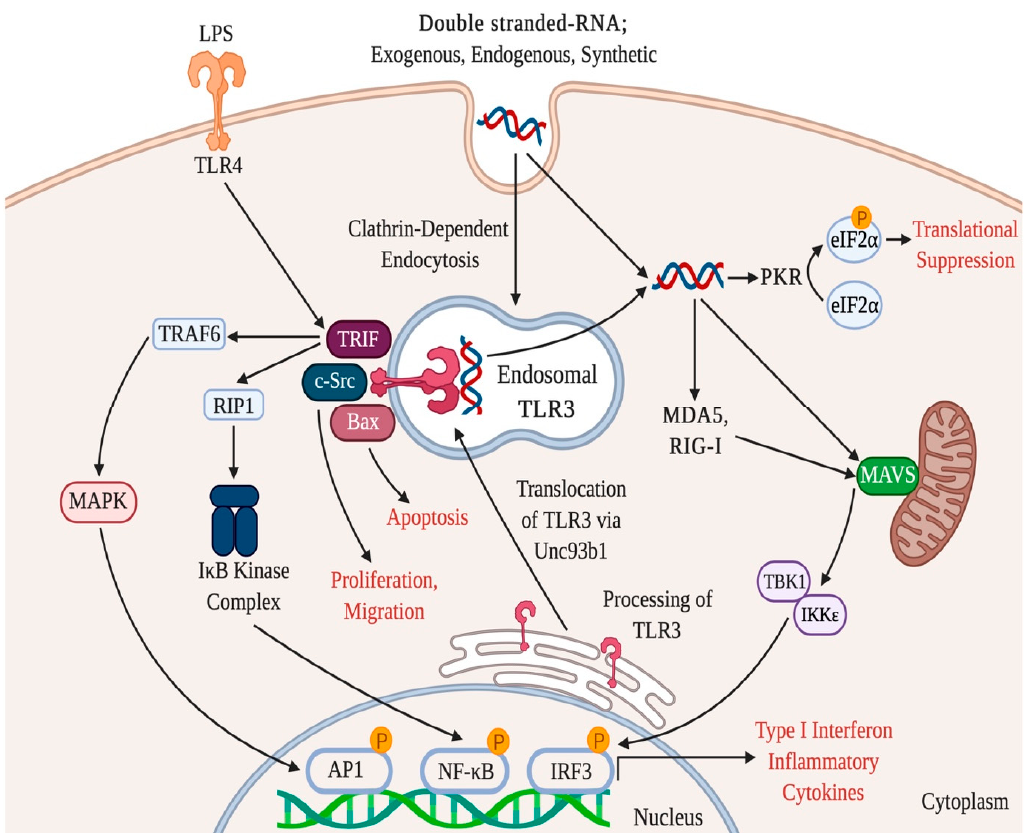
Figure 1. Intracellular TLR3 signaling pathways. Double stranded-RNA (dsRNA) derived from virus, mRNA liberated from necrotic cells and synthetic polyinosinic:polycytidylic acid are recognized by endosomal toll-like receptor, TLR3. TLR3 is located in acidic endosomes formed during clathrin- dependent endocytosis. TLR3 signaling occurs via TRIF, an adaptor that can also be recruited by TLR4. TRIF activates NF- κ B and AP1 to induce transcription of type I interferon and pro- inflammatory cytokines. Apoptosis and proliferation can be induced by TRIF-independent TLR3